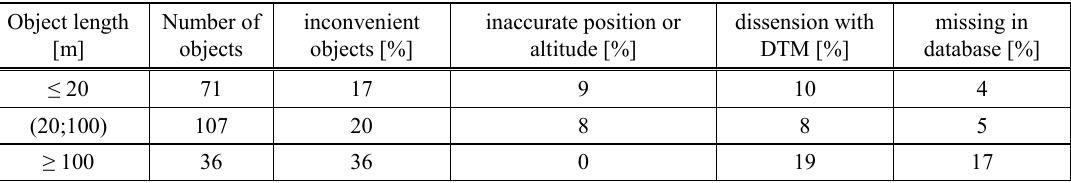
Table 6. Results of analysis for verifying suitability of ZABAGED® - altimetry as a data source for DMR 4G